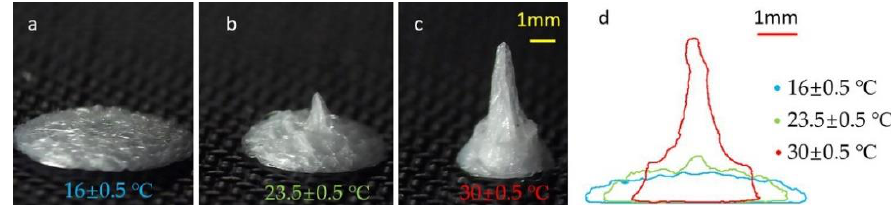
Figure 3. Comparison of fiber accumulating shape at different collector temperatures (Deposition time: 6 min. From ( a – c ), the photographs of samples at 16, 23.5 and 30 °C are shown. ( d ) The side view profiles at different collector temperatures are extracted and superimposed. The scale bars denote 1 mm).